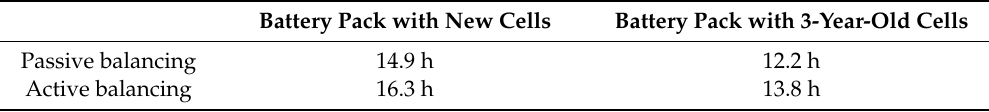
Figure 10. SOC of the cells in the battery pack with insets showing the situations at around 10% of the SOC: ( a ) passive balancing with cells at the BoL; ( b ) passive balancing with 3-year-old cells; ( c ) active balancing with cells at the BoL; ( d ) active balancing with 3-year-old cells. Table 3. Operational hours at the BoL and after 3 years with the passive and active balancing techniques.